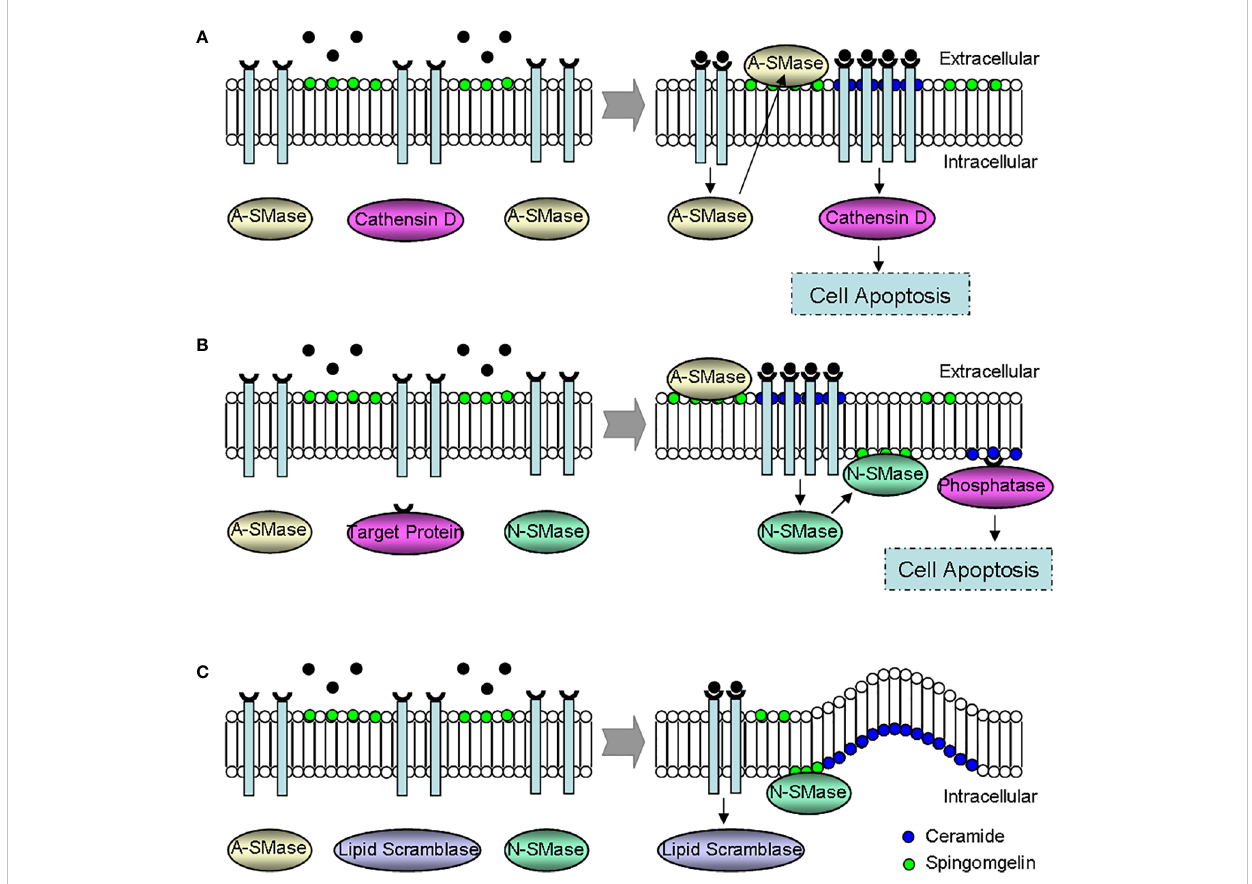
FIGURE 5 Effect mechanisms of ceramide during the regulation of cell apoptosis. (A) The instantaneous activation of A-SMase. A-SMase activation promotes ceramide-dependent receptor aggregation, leading to cell apoptosis via cathensin D. (B) The continuous activation of N-SMase. Ceramide induces cell apoptosis through the continuous activation of N-SMase and phosphatase. (C) The formation of membrane vesicles. The membrane morphology changes because of phospholipid disorder, and the membrane vesicle forms since N-SMase transforms sphingomyelin to excessive ceramide. N-SMase, neutral sphingomyelinase; A-SMase, acid